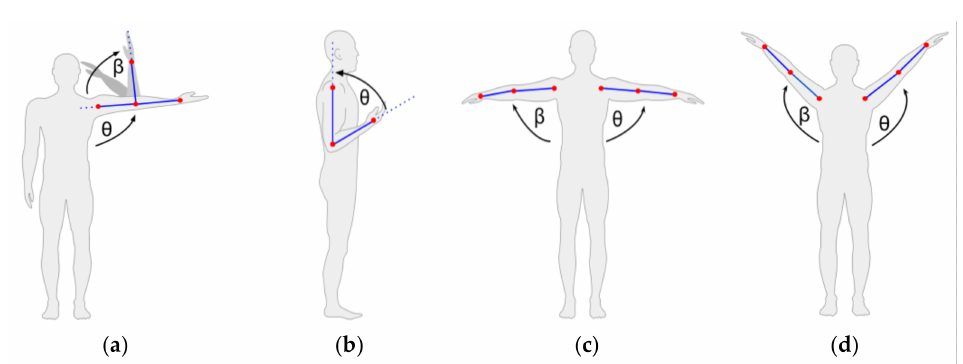
Figure 4. Rehabilitation exercises: ( a ) elbow side flexion, ( b ) elbow flexion, ( c ) shoulder extension, and ( d ) shoulder